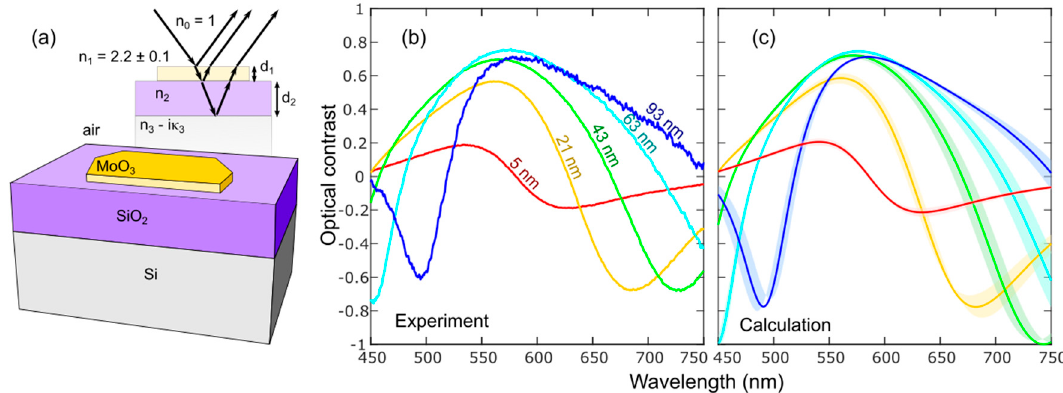
Figure 4. ( a ) Optical model used to calculate the MoO 3 optical contrast. ( b ) Optical contrast spectra measured on MoO 3 flakes, on a 297 nm SiO 2 /Si substrate, of different thickness. ( c ) Calculated optical contrast (solid lines) using the Fresnel law-based model [52]. The shaded area accounts for an uncertainty of ±1 nm in the thickness of the flake[53].